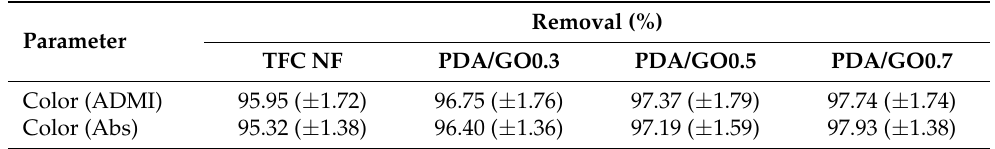
Table 6. Comparison between the separation performances of TFC NF membranes with and without PDA/GO coating layer for AT-POME